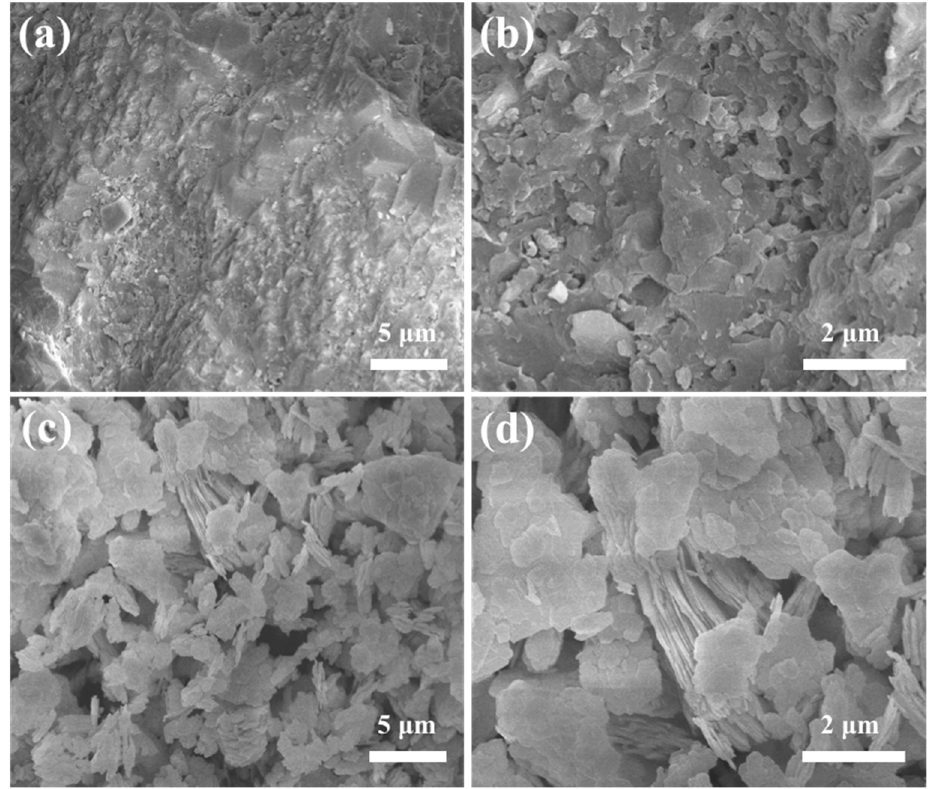
Figure 2. The morphology of the garnet ( a , b ) and metakaolin ( c , d ).